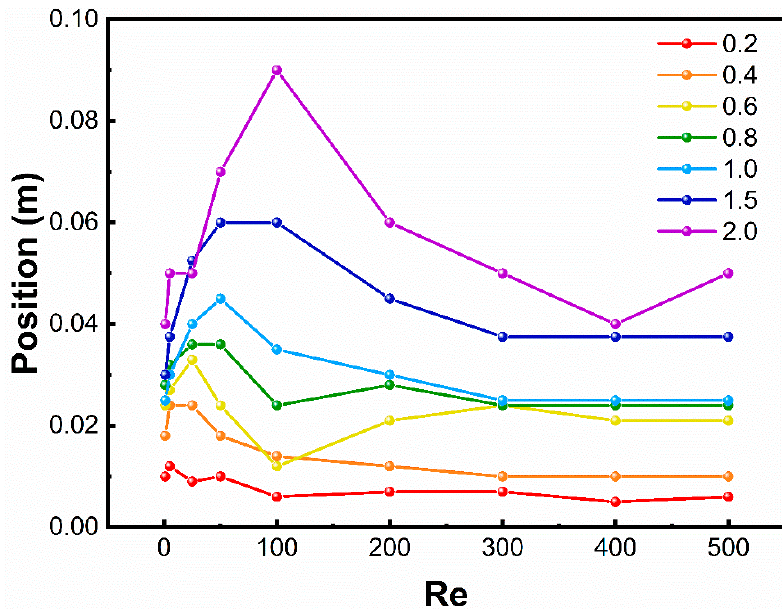
Figure 13. Effect of aspect ratio on mixer length at different Re.